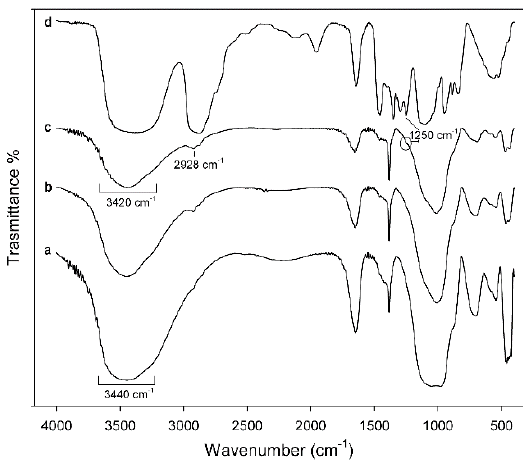
Figure 3. FTIR spectra of (a) GP0, (b) GP3, (c) GP6 after 28 days and (d) pure